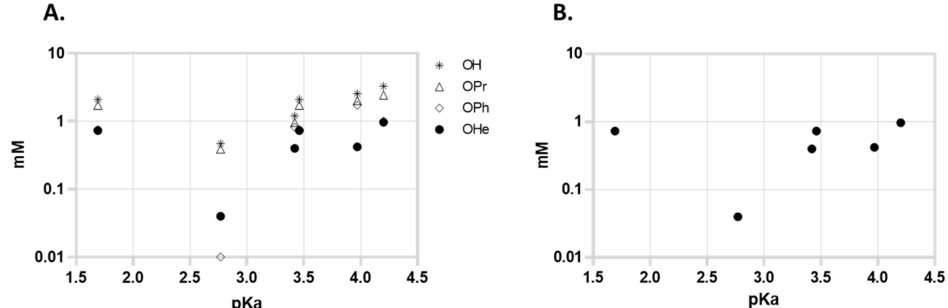
Figure 2. Activity (MIC) against M. tuberculosis in function of the pKa of the free acid of the series. ( A ) All compounds, ( B ) most active series (hexyl). Free acids: pKa: 2.6-dichlorobenzoic acid - 1.69; 3,5-dinitrobenzoic acid - 2.77; 3,5-dichlorobenzoic acid - 3.46; 4-nitrobenzoic acid - 3.42; 4-chlorobenzoic acid - 3.97; benzoic acid - 4.20. MIC are the median of 3 independent